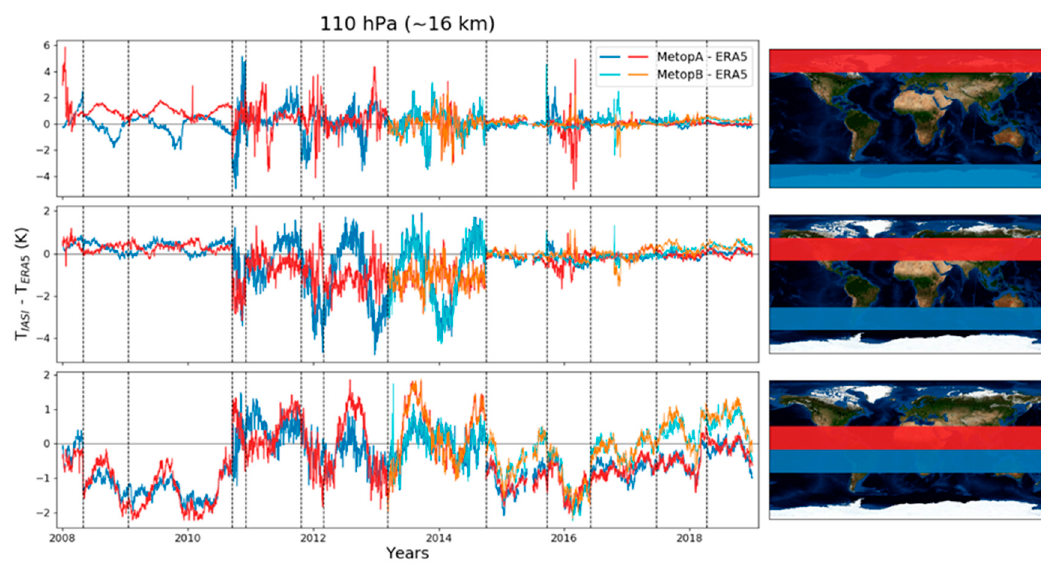
Figure 6. Differences between the IASI and ERA5 temperature at 110 hPa for Metop-A and Metop-B at the poles, mid latitudes, and equator. Note that the y-axis limit is different for the different latitude bands. The vertical dashed lines correspond to L2 updates.